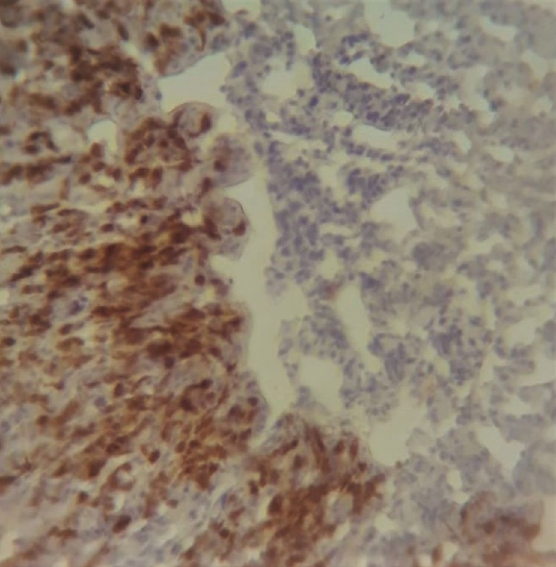
Figure 1. Section of the caecum of broiler infected by Salmonella Typhimurium ∆ ttr A∆ pdu A showing immunoreactions in macrophages, 7 days post-infection (× 400; Avidin–Biotin Streptavidin Peroxidase, counterstained with